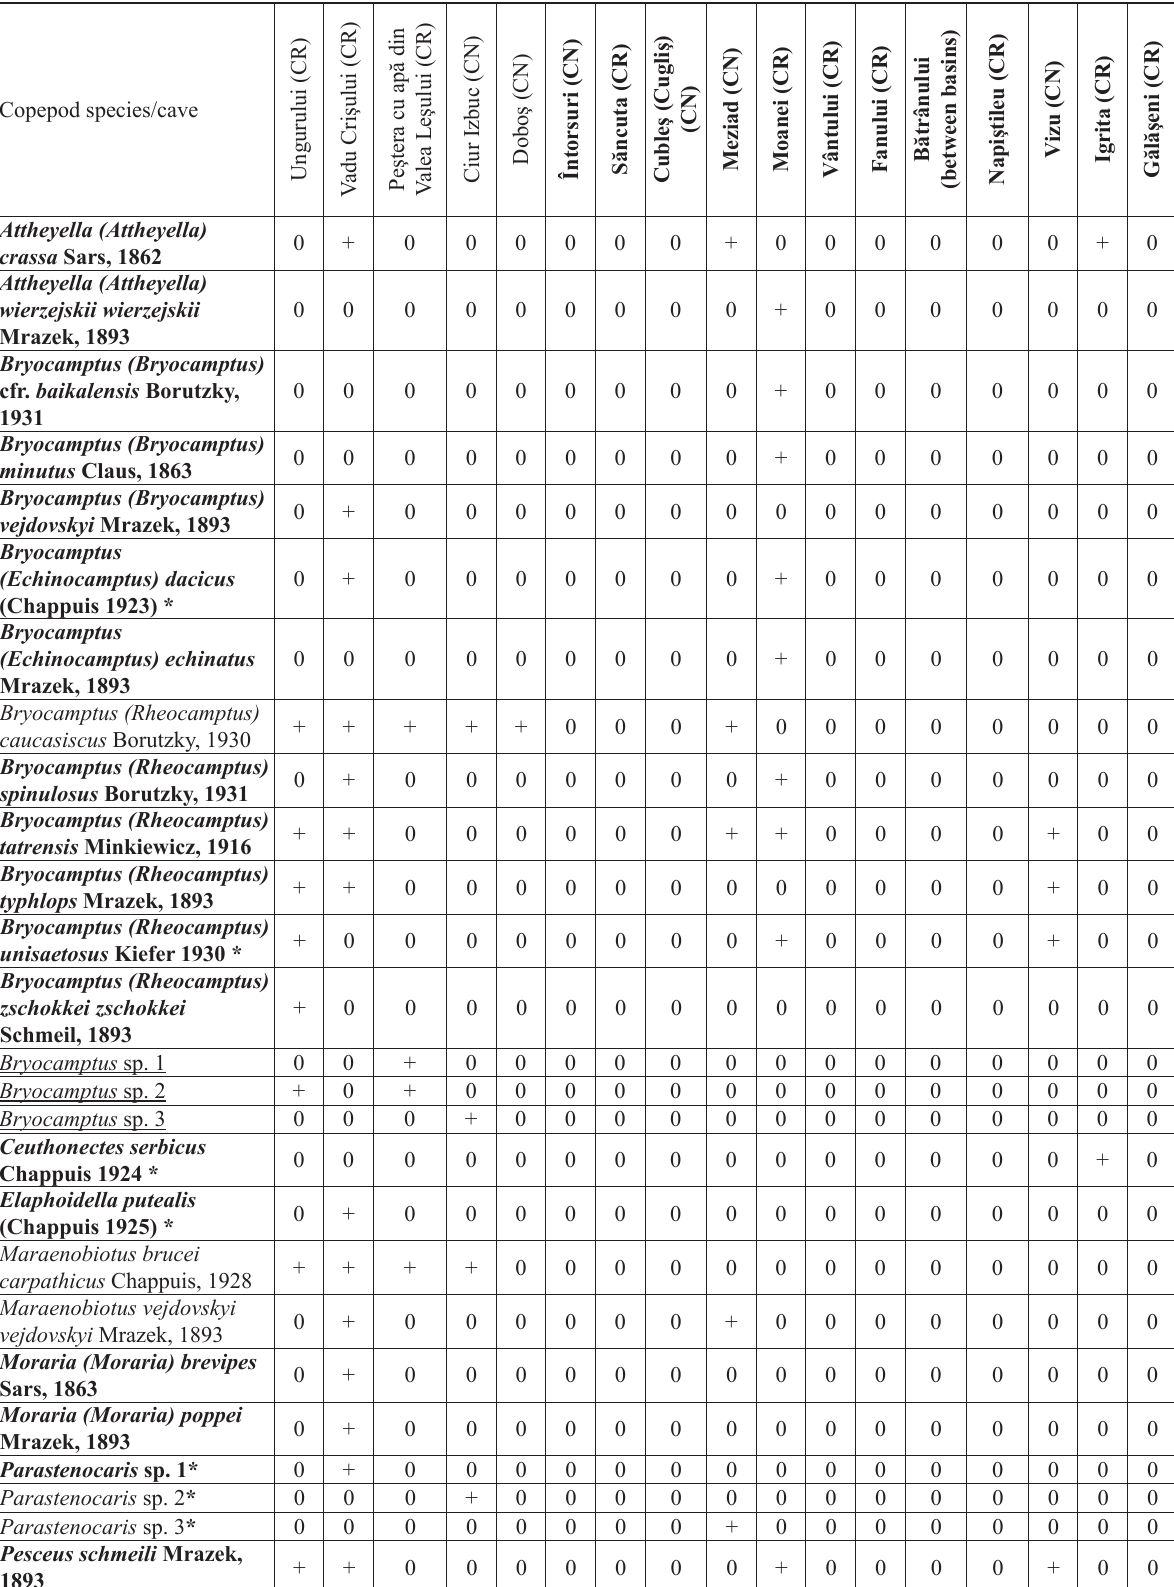
Table 1 - List of copepod species found in caves from Pădurea Craiului Mountains. Hydrographic basins are indicated between brackets (CR-Crişul Repede basin; CN-Crişul Negru basin). Data gathered from literature is indicated in bold; *-hypogean species; underlined-endemic species; 0-absence; +-presence.